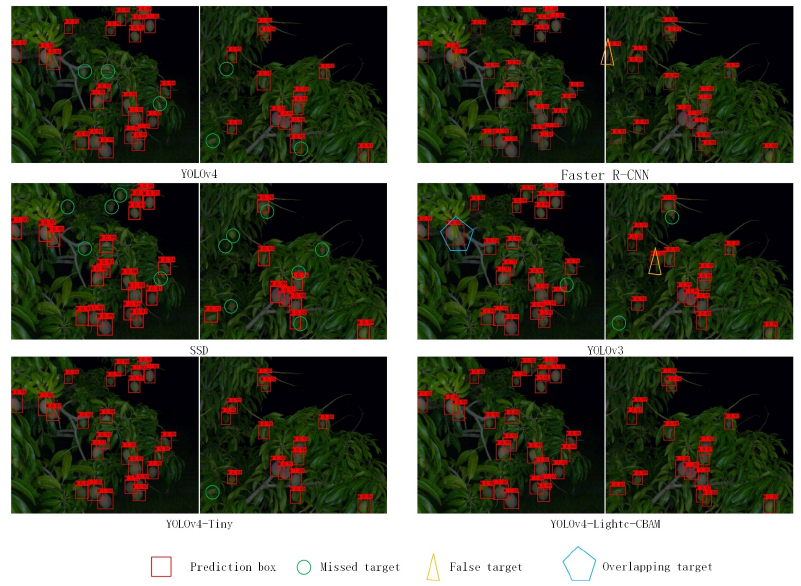
Figure 7. The experimental results of different algorithms have a total of 6 groups. The left side from the top to bottom is YOLOv4, SSD, YOLOV4 ‐ Tiny, respectively. The right side from top to bottom is Faster R ‐ CNN, YOLOv3, YOLOV4 ‐ light ‐ CBAM,